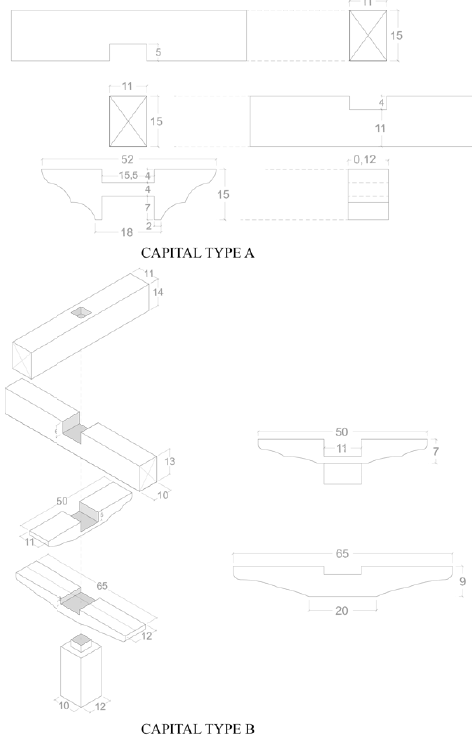
Figure 8. Detail of structural assemblies (Authors).